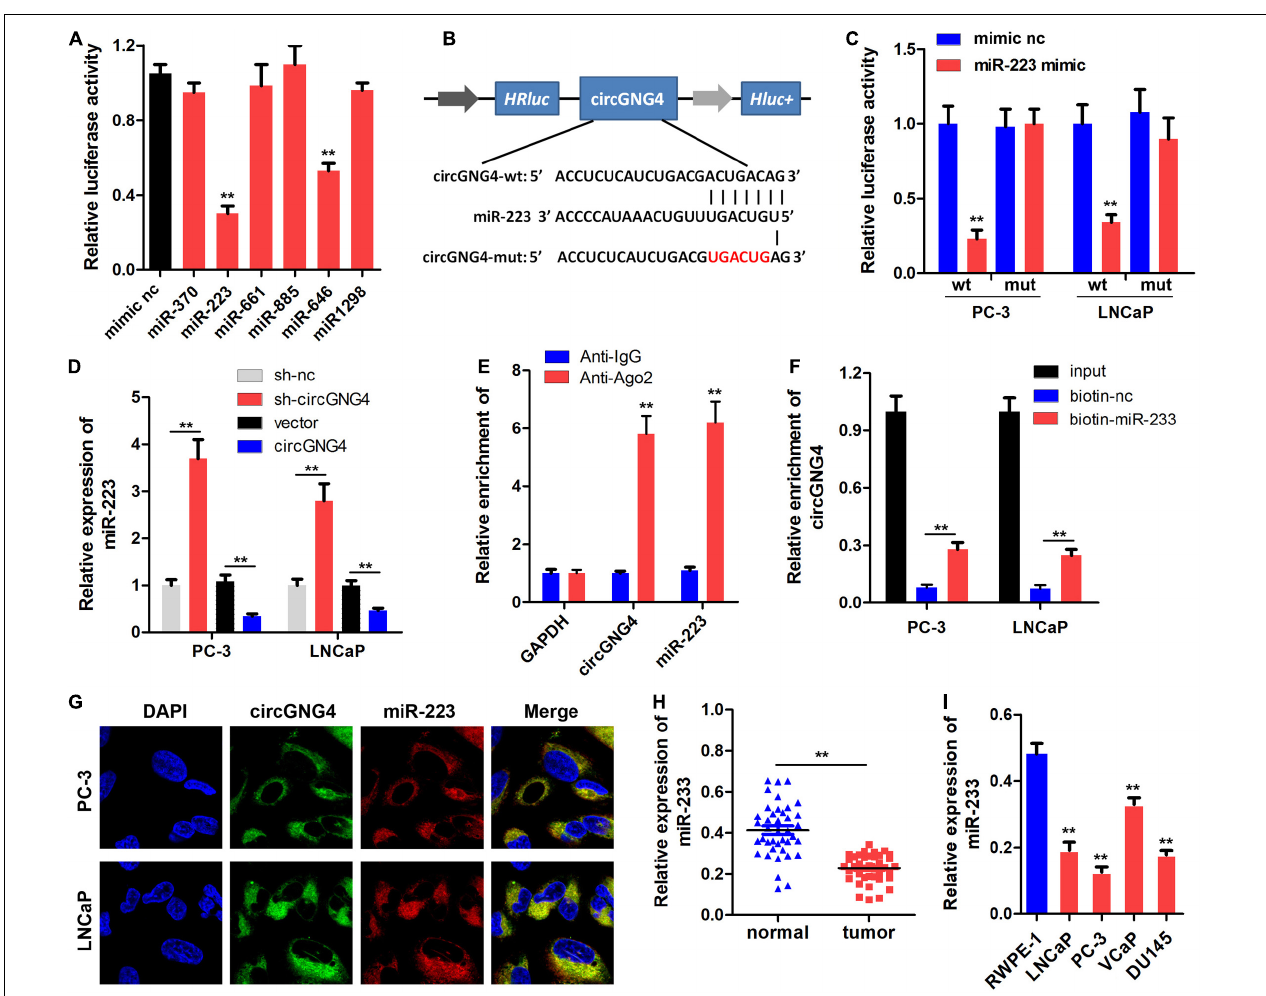
FIGURE 3 | CircGNG4 spongesmiR-223in prostate cancer cells. (A) Candidate miRNAs bound to circGNG4 were screened using a dual luciferase reporter assay. (B) The binding site between circGNG4 and miR-223 was predicted using bioinformatics analysis. (C) Dual luciferase reporter assay confirmed the binding between circGNG4 and miR-223. (D) After circGNG4 knockdown or overexpression, miR-223 expression level was detected by quantitative PCR. (E) RNA immunoprecipitation assay using Ago-2 antibody was performed to detect the interaction between circGNG4 and miR-223 with Ago-2 protein. (F) RNA pull-down using a biotin-labeled miR-223 probe was carried out to detect the interaction between circGNG4 and miR-223. (G) Fluorescence in situ hybridization was performed to detect the co-localization between circGNG4 and miR-223. (H) Expression of miR-223 in prostate cancer tissues was detected. (I) Expression of miR-223 in prostate cancer cell lines was detected. ** p < 0.01 vs. mimic NC, anti-IgG and RWPE-1 group. circRNA/circ, circular RNA; GNG4, G protein subunit γ 4; sh, short hairpin RNA; NC, negative control; miR/miRNA,